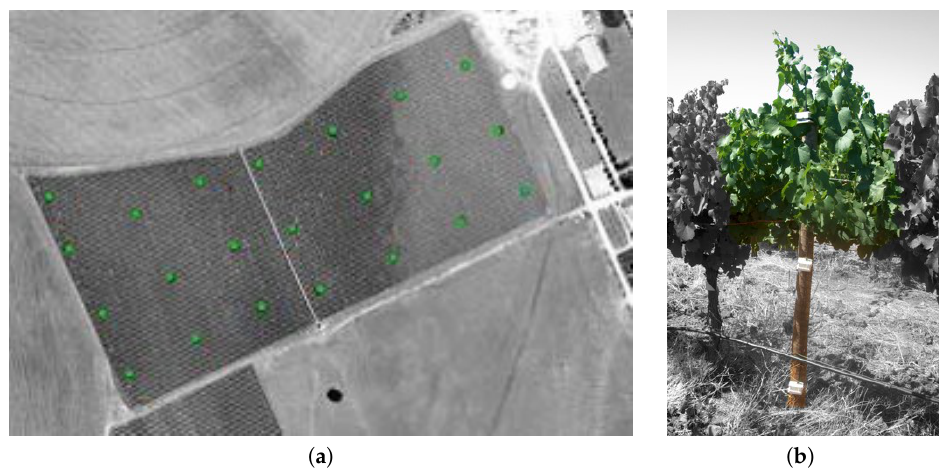
Figure 1. Full operational prototype of Wisevine Project. ( a ) Nodes location in the vineyard; ( b ) Placed devices.